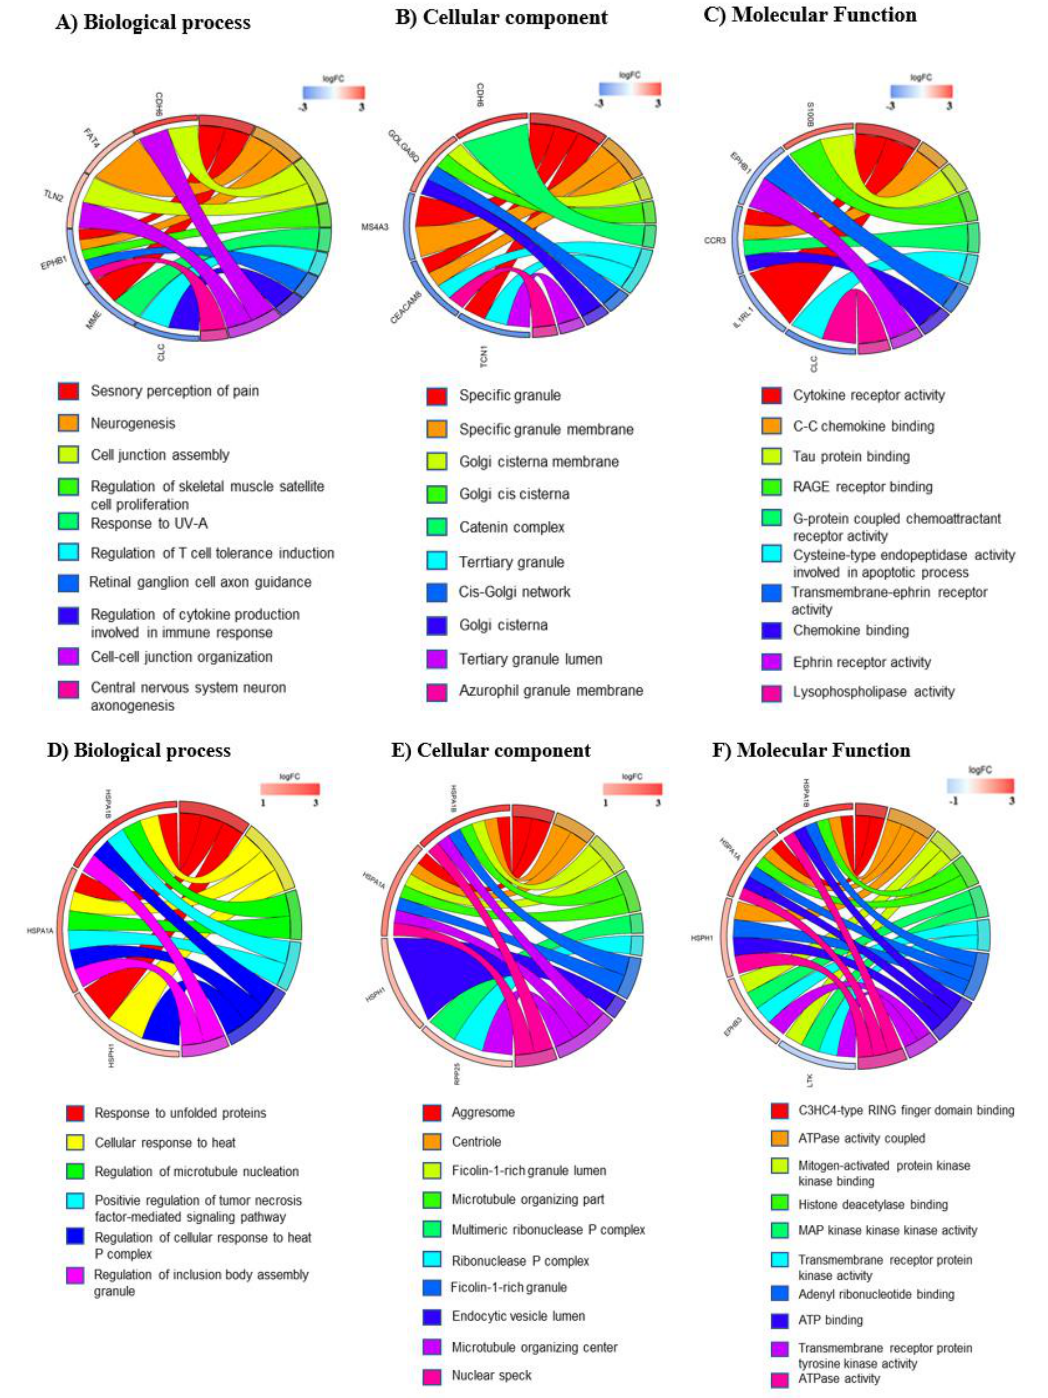
Figure 5. GO chord plot. Chord plot showing significantly enriched GO terms for biological process ( A , D ), cellular component ( B , E ) and molecular function ( C , F ) in low ( A – C ) and in high ( D – F ) nSOD1. The left of the plot shows the genes contributing to the enrichment, arranged in order of their logFC, which is displayed in descending intensity of red squares for the upregulated genes and blue squares for the downregulated ones. The genes are linked to their assigned terms via colored